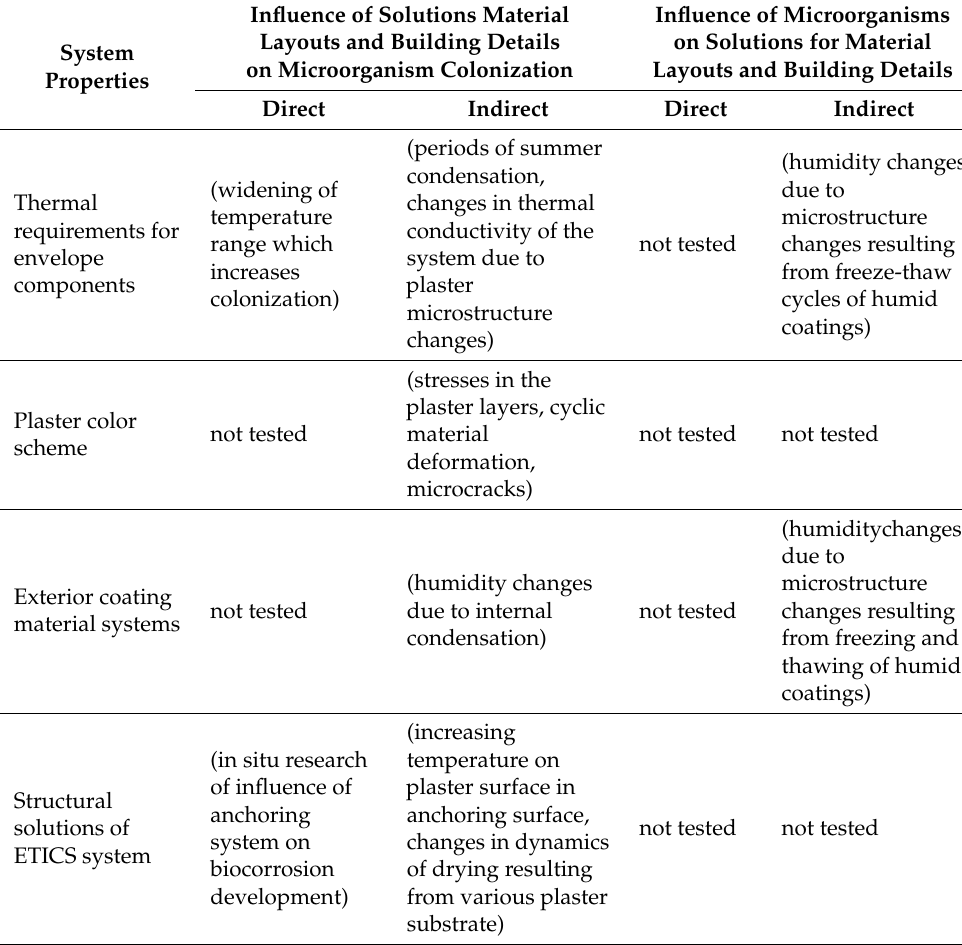
Table 5. Relationship between solutions for material layouts and building details and microbial